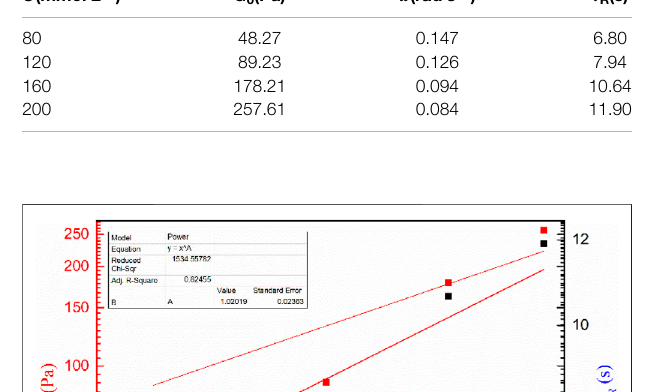
FIGURE4| ShearviscosityversustotalconcentrationoftheMSA/CTAB system.